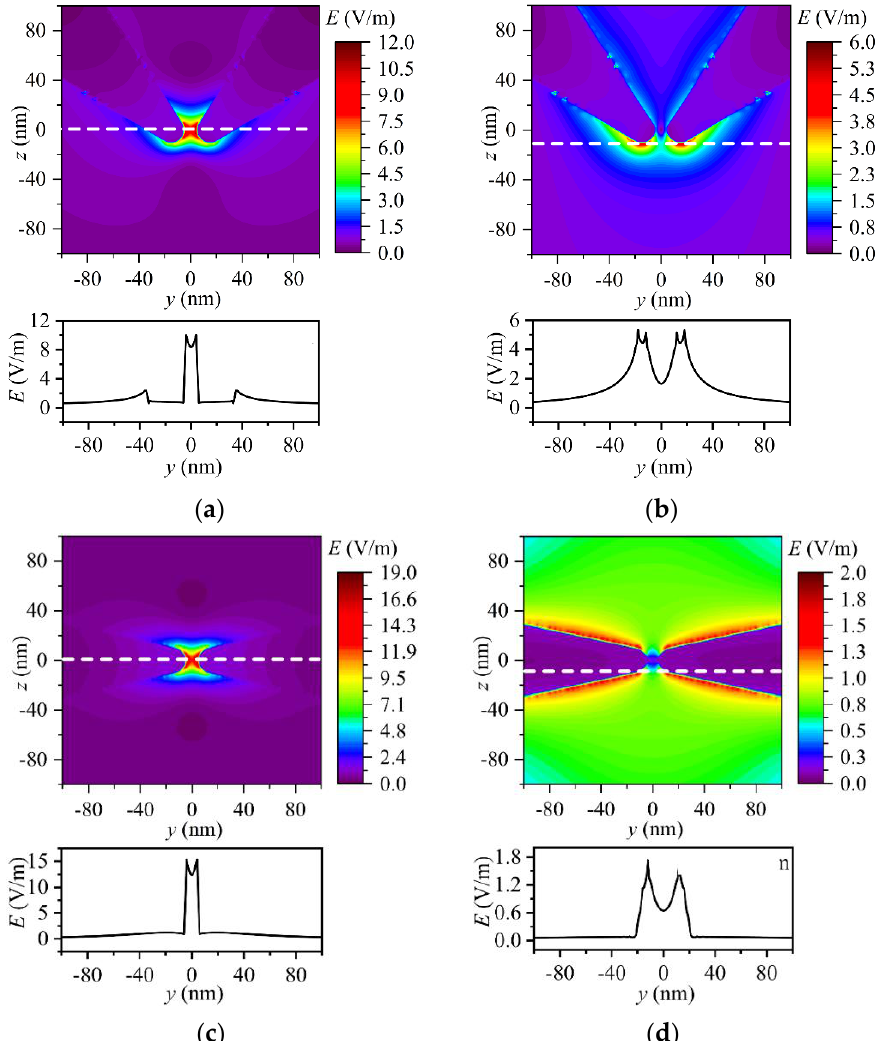
Figure 3. Distributions of electric fields in y-z plane (top diagram) and along y direction (bottom diagram; the white dash lines in top diagram show the paths) around dual probe irradiated by polarized near-field laser. ( a ) ODPs irradiated by HP laser; ( b ) ODPs irradiated by VP laser; ( c ) CDPs irradiated by HP laser; ( d ) CDPs irradiated by VP laser.